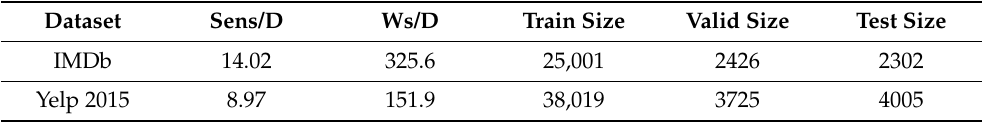
Table 1. Statistical features of the IMDB and Yelp 2015